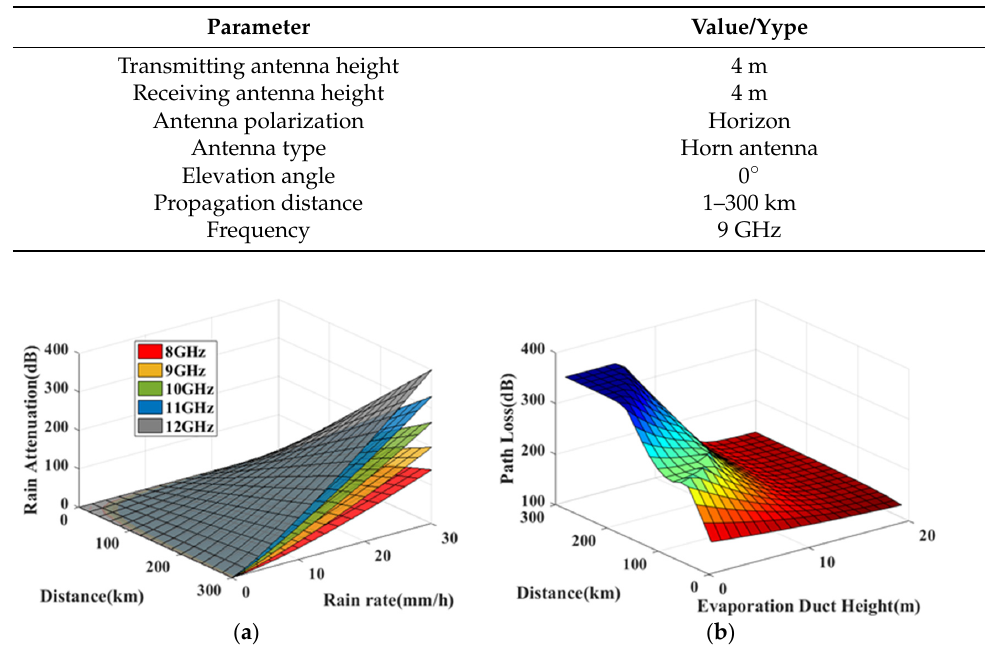
Table 4. Simulation parameters.